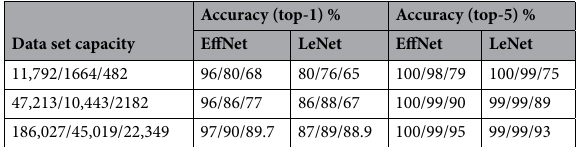
Table 2. Classification accuracy for different CNN